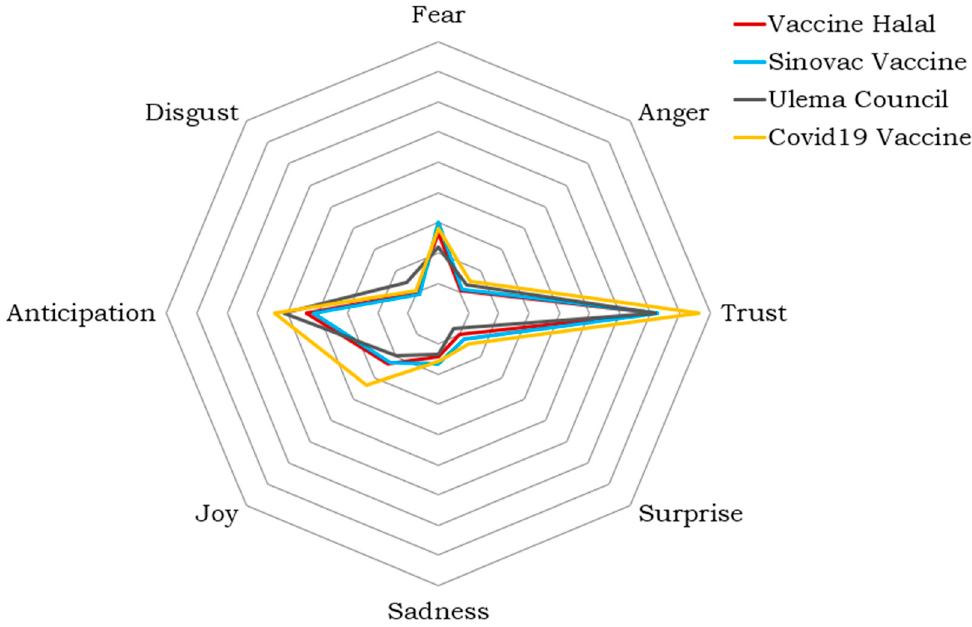
Figure 10. Emotion analysis for Facebook posts.